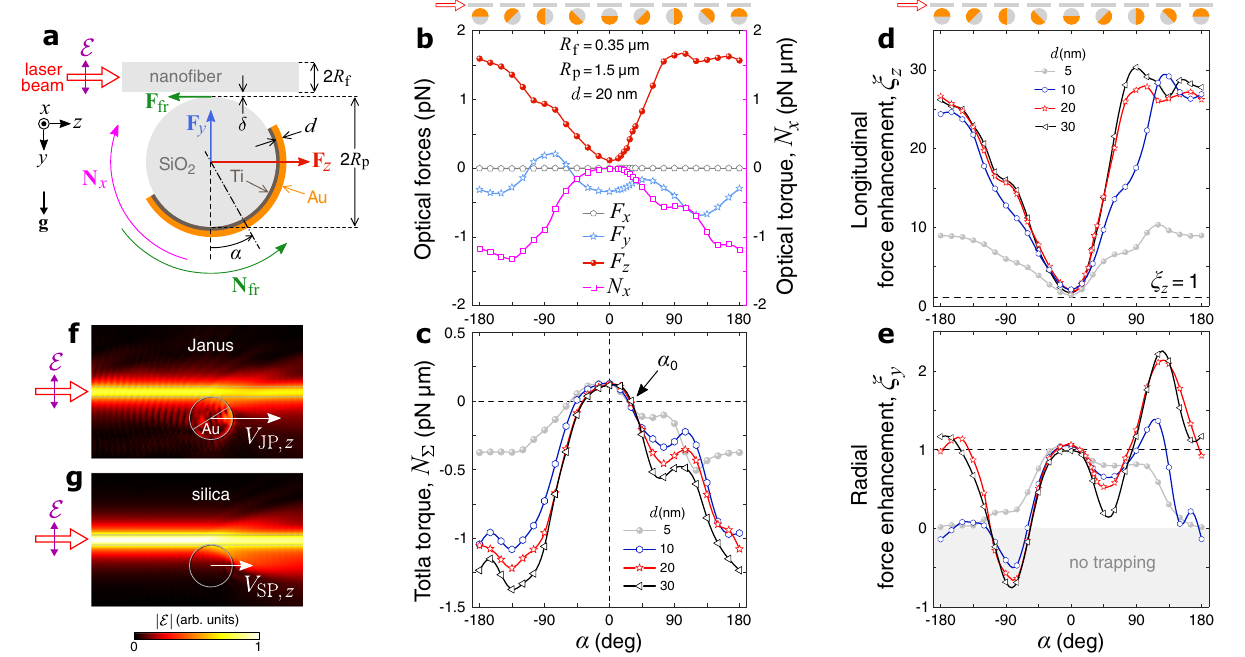
Fig. 2 | Numerical simulations of optical fi elds, forces, and torques in the particle-nano fi bersystem.a Modelschematics,where E istheelectric fi eldvector; g is the gravitational acceleration; N x is the optical torque; N fr is the torque pro- duced by the friction force, F fr ; F z and F y are the longitudinal and radial optical forces,respectively. b Opticalforcesandtorqueversusthegoldcaporientationfor different coating thickness, d . c Total torque, N Σ = N x + N fr = N x − μ F y R p . d, e Force